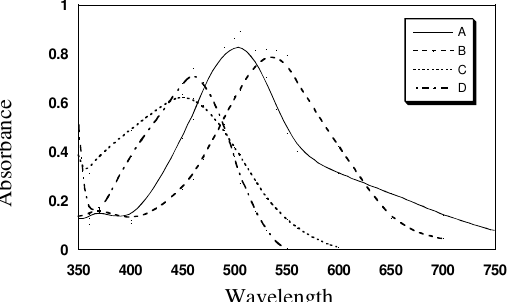
Figure 1. Abrorption spectra of the reaction between fast red B salt solution and (A) secnidazole 15 µg.mL -1 , (B) niclosamide 8.75 µg.mL -1 (C) nifuroxazide 10 µg.mL -1 and (D) sulphasalazine 11.25 µg.mL -1